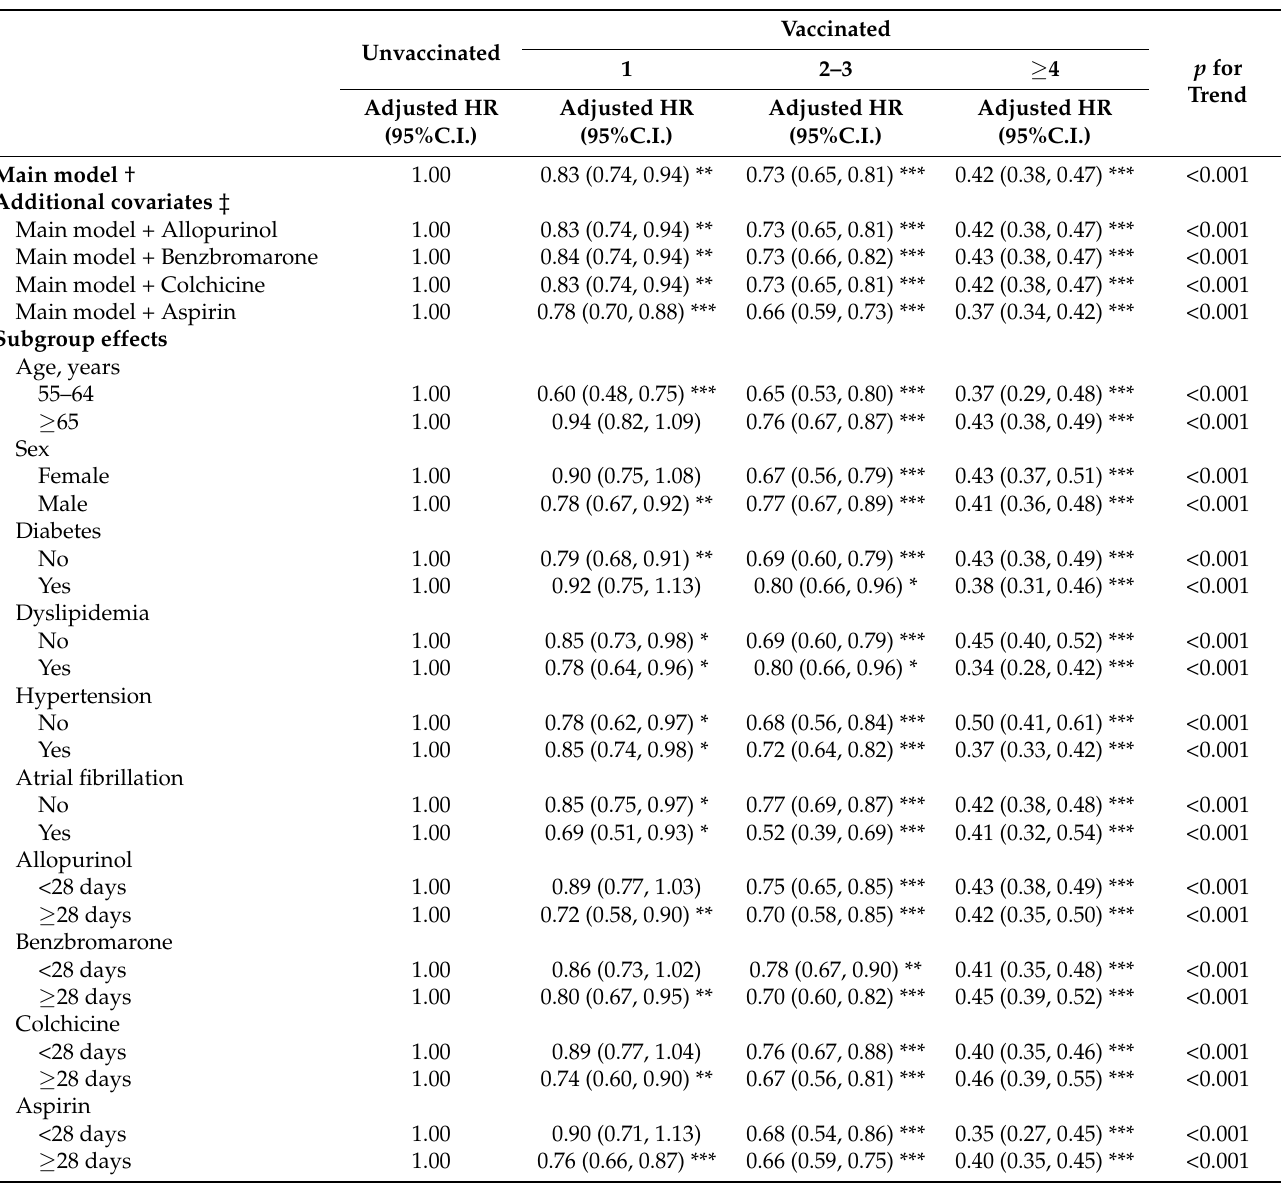
Table 4. Sensitivity analysis of adjusted HRs of vaccination in the risk reduction of ischemic stroke in all season.